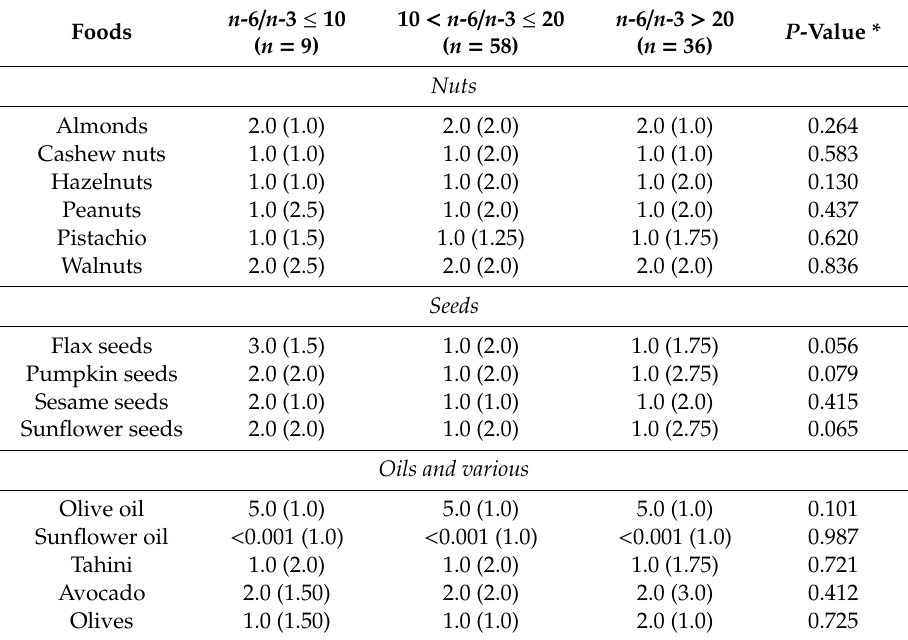
Table 5. Frequency of consumption of foods according to n -6 / n -3 ratio.